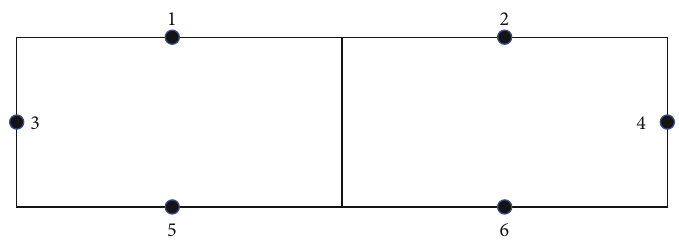
Figure 8: Earth pressure measuring point layout of upper tunnel.